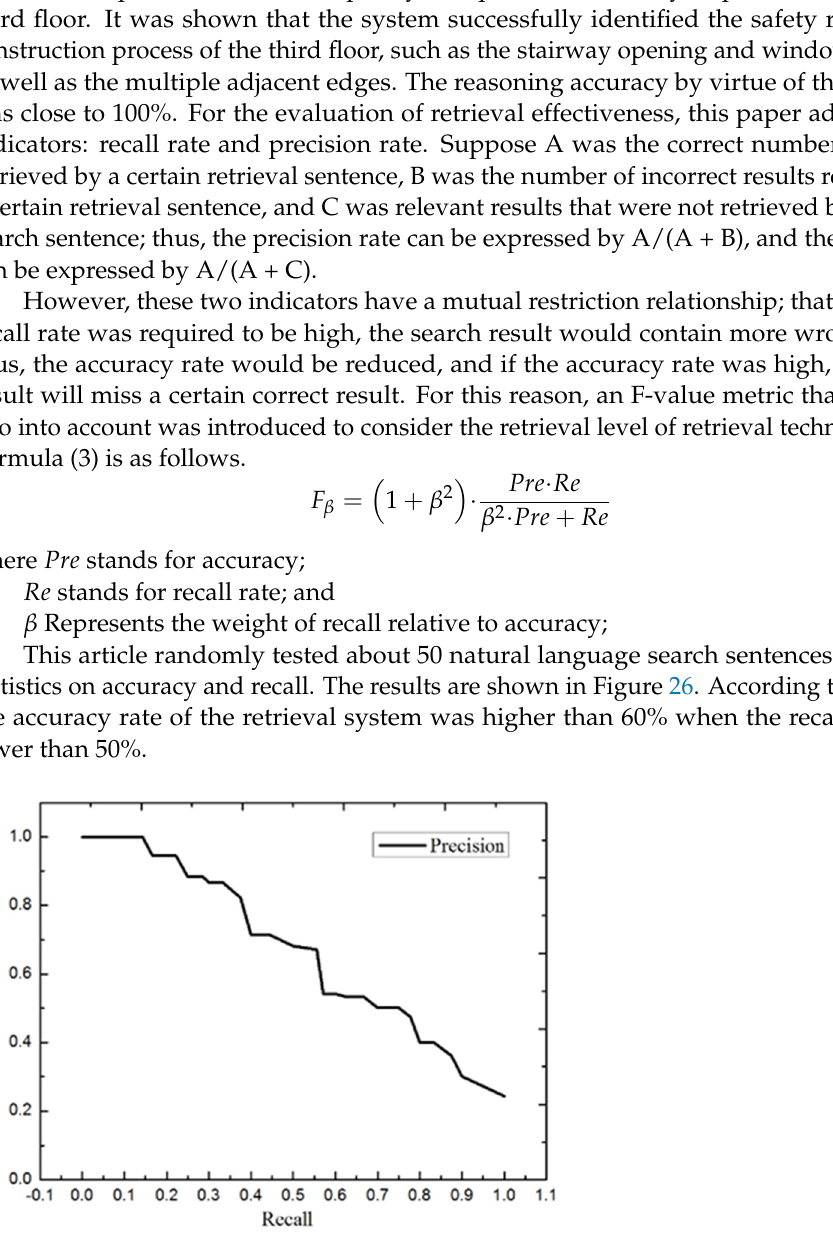
Figure 26. Retrieval recalls and precision